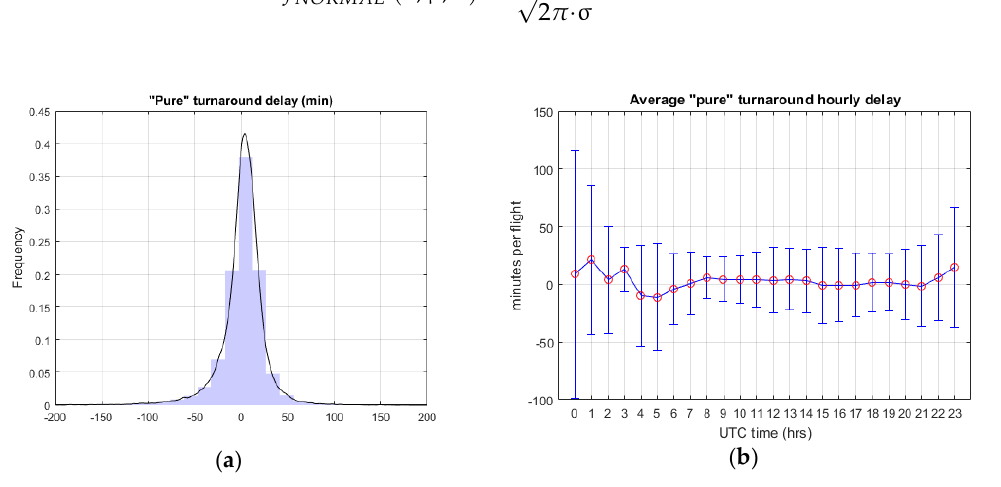
Figure 10. “Pure” turnaround delay (without considering the ATFCM delay): ( a ) histogram/curve fitting and ( b ) average hourly delay (min/operation) throughout the day (the error bars denote intervals of one standard deviation).